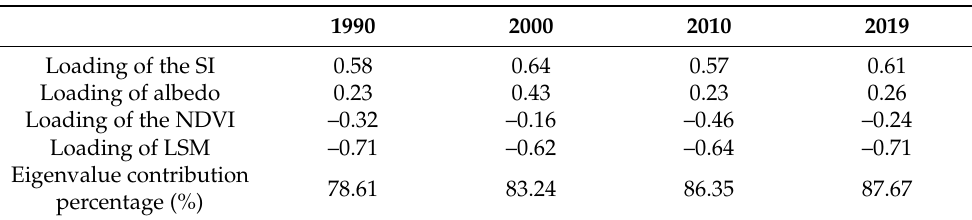
Table 1. Loadings of the four selected variables on the first principal component (PC1) and associated contributions in different study years.